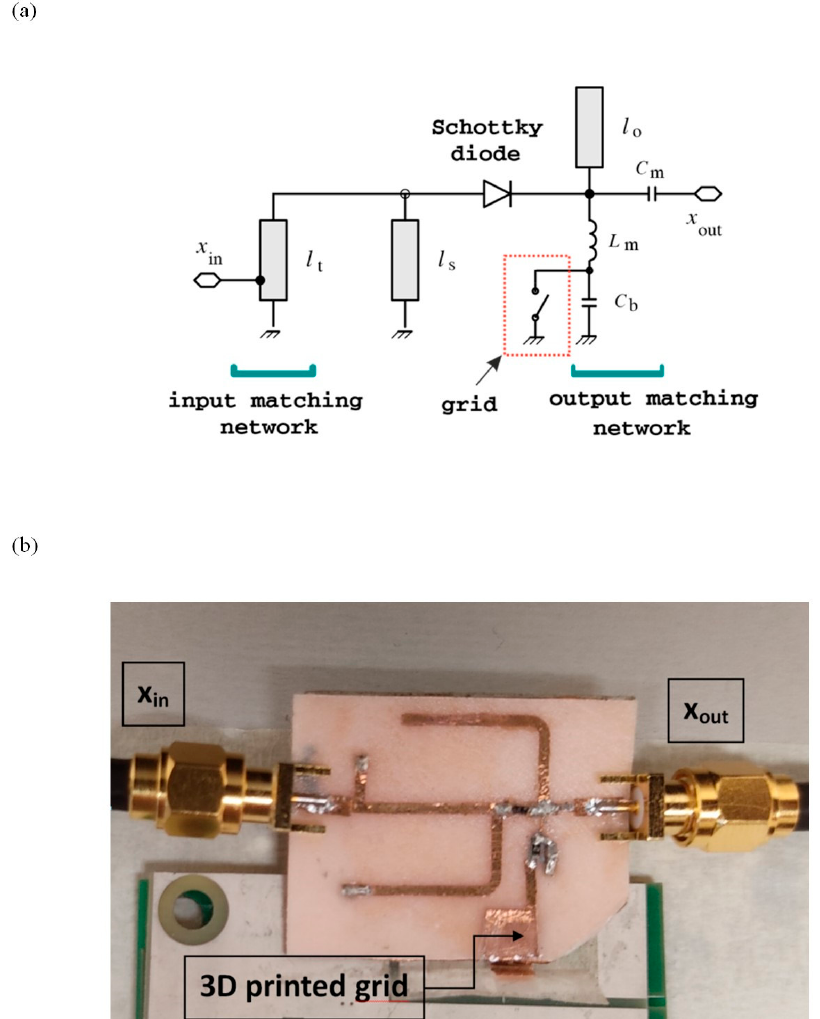
Figure 8. ( a ) Circuit schematic. Main circuit parameters: l t = 17 mm, l s = l o = 21.5 mm, C m = 0.5 pF, L m L m = 1.3 nH, and C b = 100 pF. ( b ) Photo of the shock sensor = 1.3 nH, and C b = 100 pF. ( b ) Photo of the shock sensor prototype.